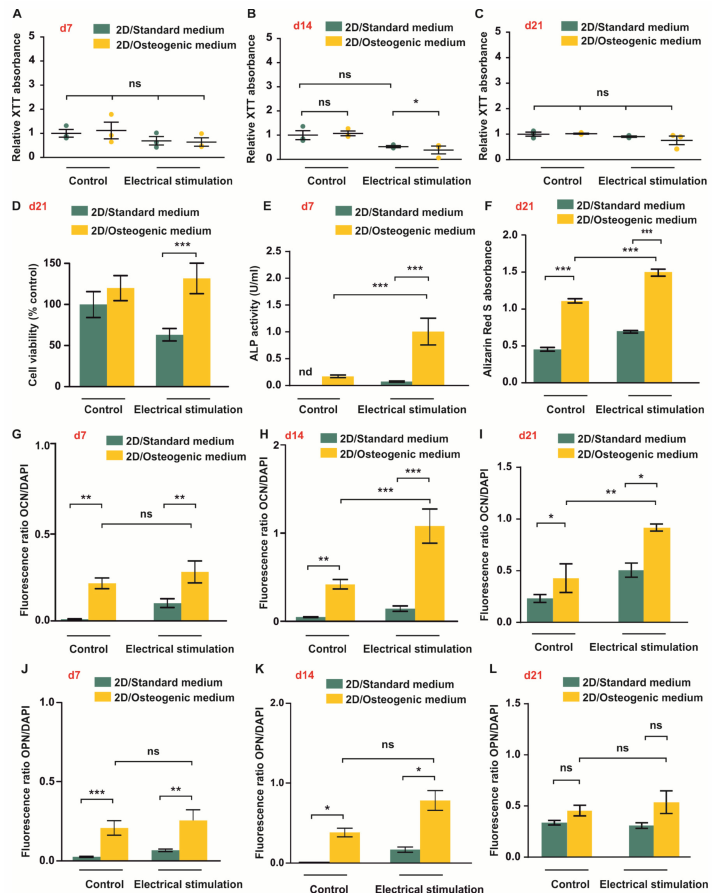
Figure 2. Electrical stimulation (ES) increases osteogenic di ff erentiation of Adipose-derived stem cells (ASCs) under 2D cell culture conditions. ( A – C ) ASCs were exposed to ES in standard and osteogenic medium for up to 21 days followed by assessment of viability using XTT assays. At d7 and 21 ES, no significant di ff erences in viability were detected. At d14, ES of cells in osteogenic medium slightly decreased the viability compared to cells exposed to ES in standard medium. ( D ) Calcein / ethidium homodimer-1 based live / dead assay. Cells were cultivated in 2D in standard or osteogenic di ff erentiation medium with or without ES for 21 days followed by a live / dead assay. Data analysis revealed no di ff erences in relative viability in osteogenic di ff erentiation medium compared to control cells and a higher relative viability in cells subjected to osteogenic di ff erentiation and ES compared to cells in standard medium with ES. ( E ) After seven days, cells were assayed for activity of ALP. A significant increase of ALP activity was observed in cells in osteogenic medium exposed to ES compared to non-stimulated cells under osteogenic conditions. ( F ). Mineralisation was assessed by Alizarin Red S assay on d21. ES in osteogenic medium significantly increased the levels of mineralisation compared to cells cultivated under osteogenic conditions without ES. ( G – I ) Immunocytochemical analysis of osteocalcin (OCN) at d7, d14, and d21. Cells in 2D were subjected to ES in standard of osteogenic medium for up to 21 days followed by immunocytochemical staining and fluorescence microscopy. At d14 and d21, significantly higher expression levels of OCN were observed in cells in osteogenic di ff erentiation medium exposed to ES compared to osteogenically di ff erentiated cells without ES. ( J – L ) Quantification of immunocytochemical analysis of osteopontin (OPN) expression at d7, d14, and d21. No significant di ff erences in OPN expression were found at d21, whereas ES of cells in osteogenic medium significantly increased OPN expression at d7 and d14 compared to cells in osteogenic conditions with and without ES, respectively. No significant di ff erences were found between cells in osteogenic medium with and without ES at all time points. Error bars: SEM. * p < 0.05, ** p < 0.01, *** p < 0.0001. ns: not significant. nd: not